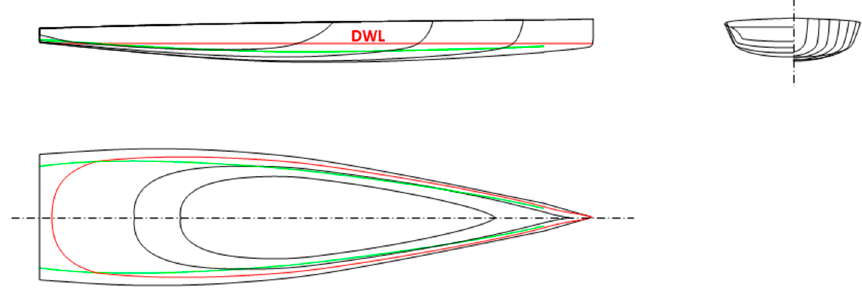
Figure 19. The lines of the new design. Table 3. Comparison of the coefficients of LED, TryAgain and LED_UP_06. Coeff.